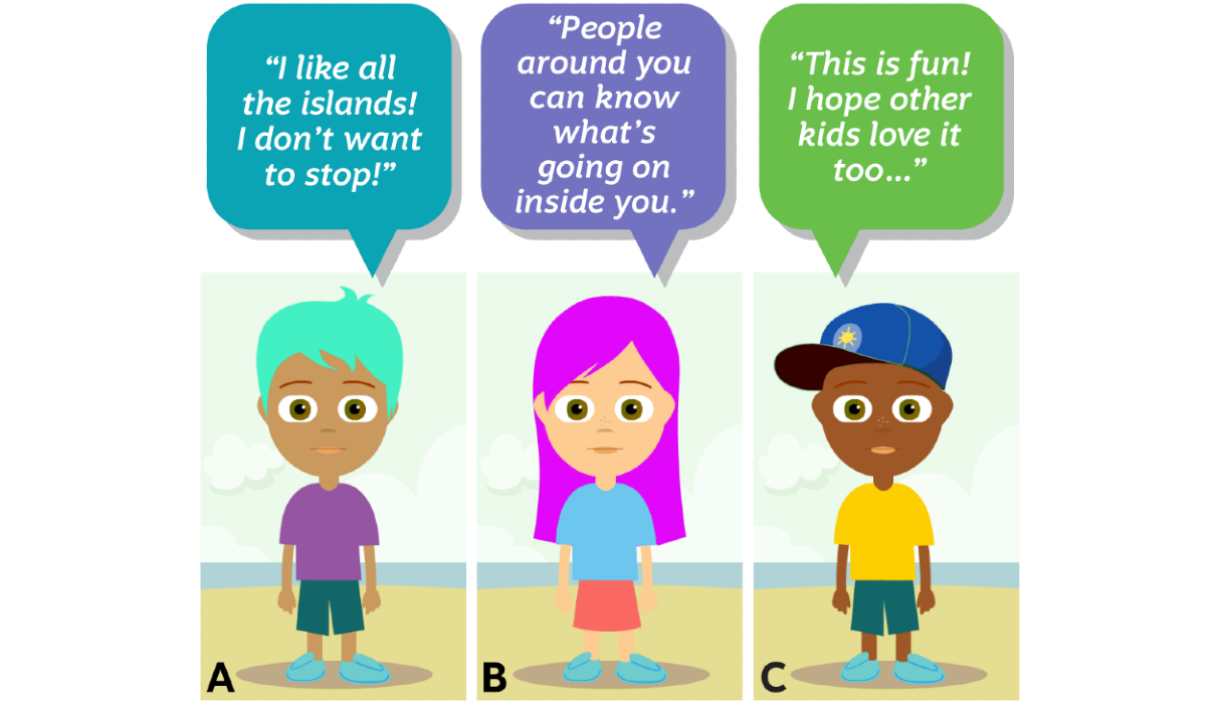
Figure 1. General impressions of Sisom. A. Quote by Participant #6, 6 years old. B. Quote by Participant #4, 8 years old. C. Quote by Participant #5, 10 years